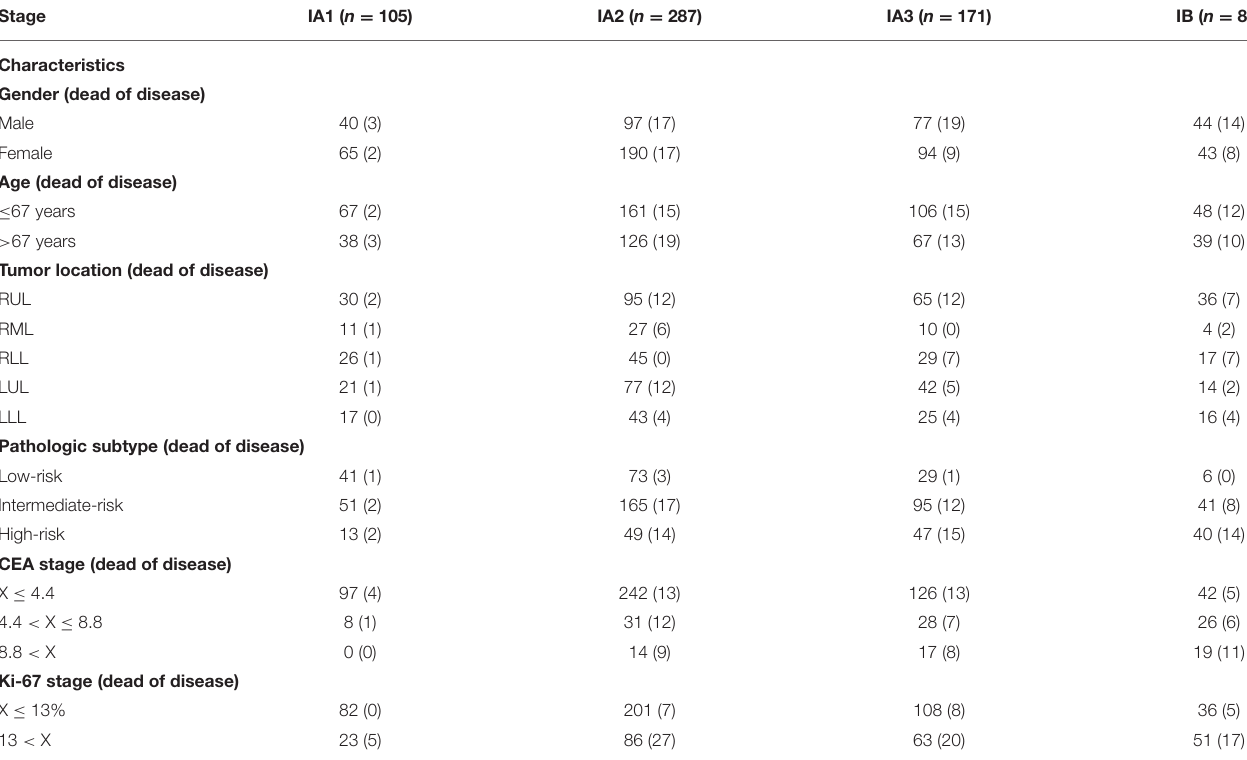
TABLE 1 | Summary of patient cohort and characteristics in patients with stage I pulmonary adenocarcinoma ( n =